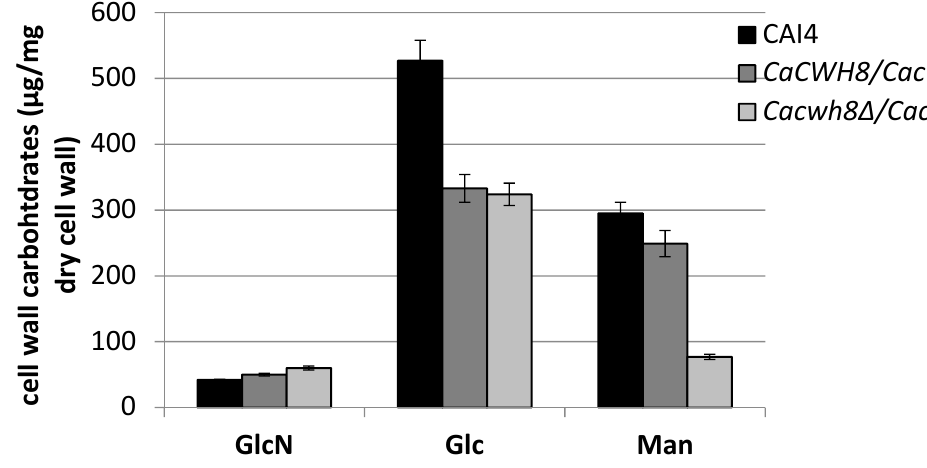
Figure 12. Cell wall carbohydrate composition of wild type CAI4 strain and the CaCWH8 mutants.